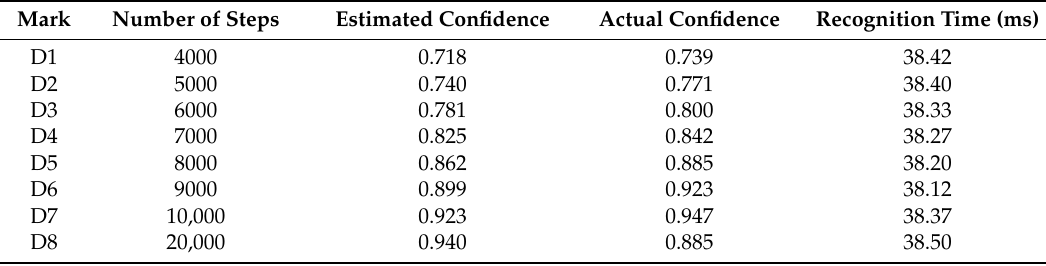
Table 2. Performance of BB 2 model under different